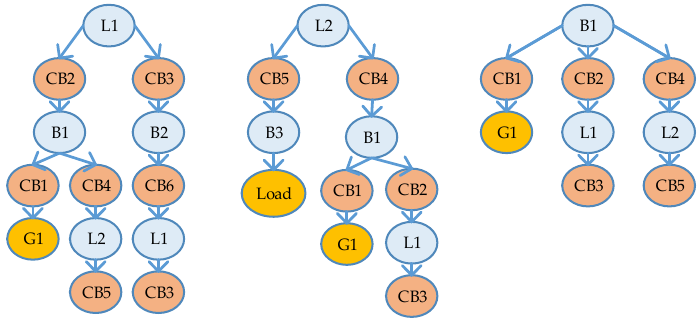
Figure 4. Protection information connection tree of L1, L2 and B1.